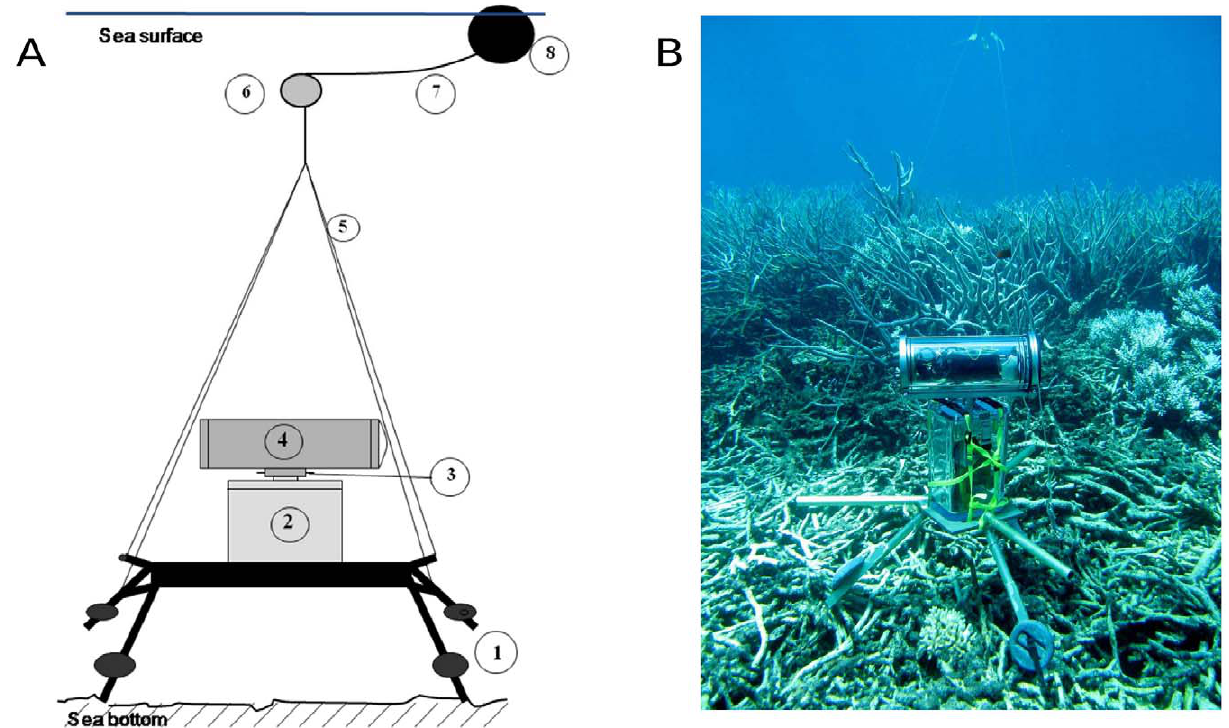
Figure 1. Description of the underwater rotating video system. (A) 1) weighted aluminium support; 2) engine housing; 3) rotating axis; 4) video camera housing; 5) nylon fishing line; 6) intermediate buoy; 7) floating rope; 8) surface buoy. (B) picture of the system in place.